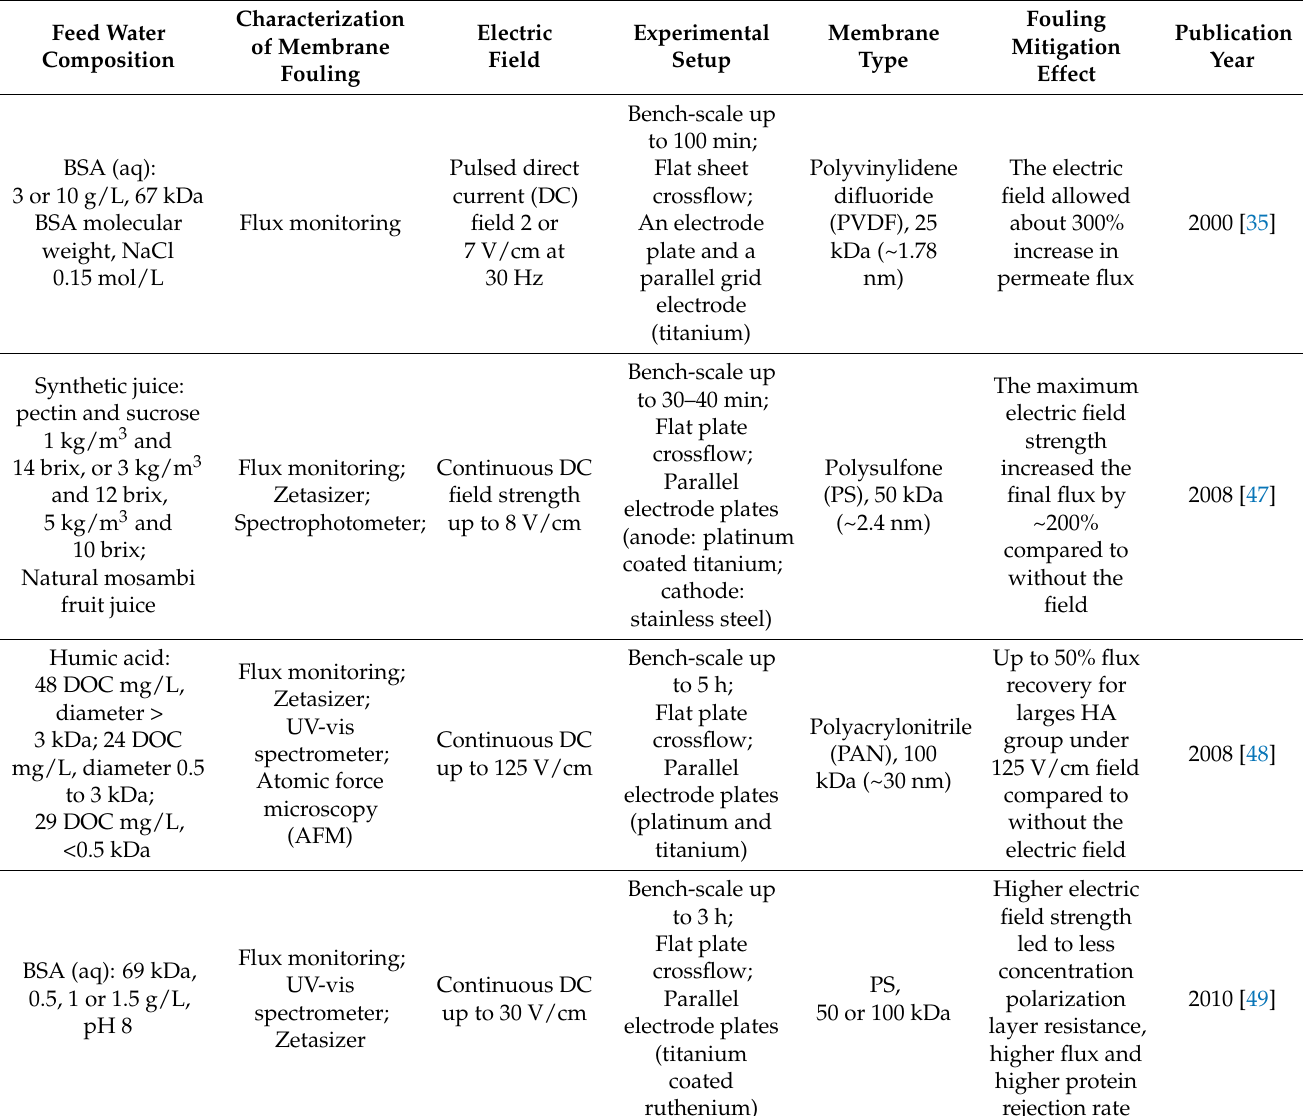
Table 2. Summary of electrofiltration studies for